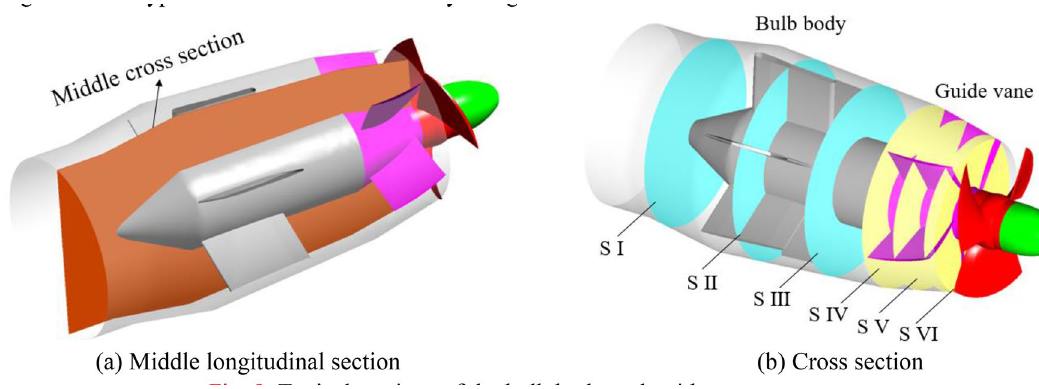
Figure 9. Typical sections of the bulb body and guide vane.